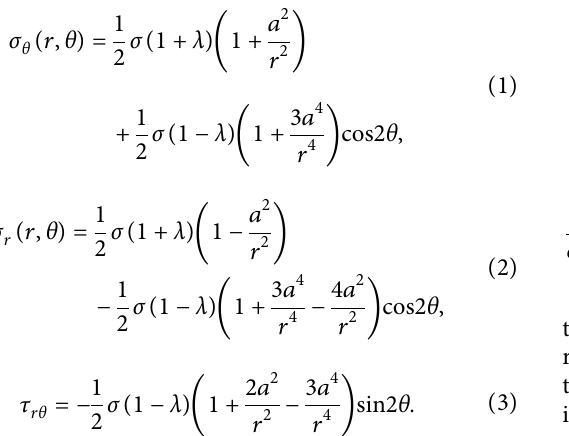
Formulas (1) and (2) are normalized and then r is derived to obtain the normalized tangential and radial stress change rates of surrounding rock.